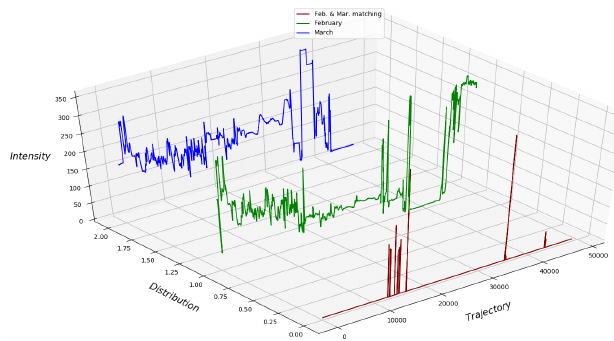
The baseline can change between any of the recorded distributions. Analyzing the observed similarities between Γ I 1 T and Γ I 2 T leads to the discovery of a unique spatiotemporal lightmorphic shape as represented in figure 5: